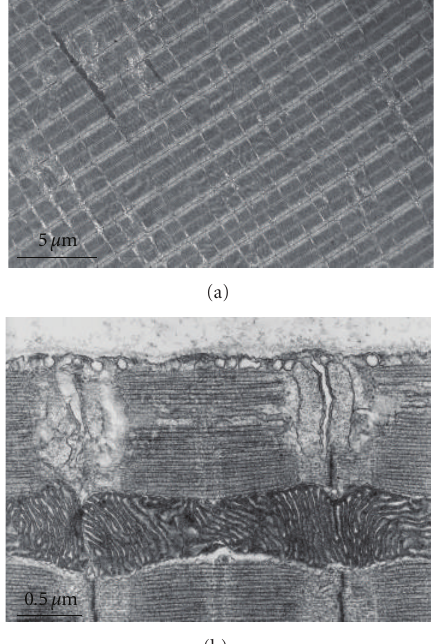
Figure 5: Images from the frog gastrocnemius (a) and sartorius (b) in longitudinal sections. The predominant location of mitochon- dria is similar to that of birds and reptiles, again providing limited contacts with CRUs. Note overall scarcity of mitochondria in these muscles gastrocnemius. Others have more frequent mitochondria but still no large clusters at the periphery.